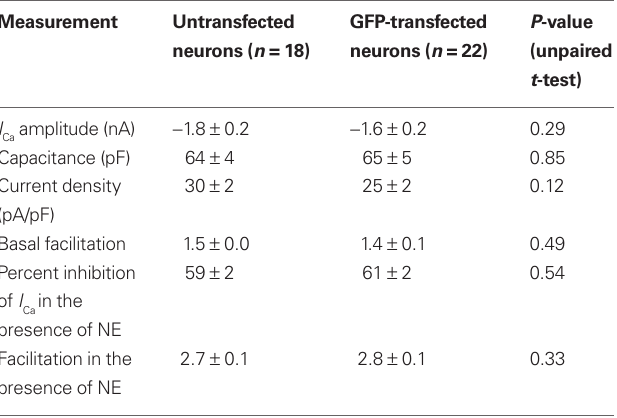
Table 1 | The effect of gFP mrNA transfection on Ca 2 + currents and Ne-mediated Ca 2 + current inhibition in SCg neurons. Characteristics of endogenous Ca 2 + currents were measured in untransfected SCG neurons and neurons transfected with 3.1 μg of GFP. Facilitation was calculated from the ratio of postpulse Ca 2 + -current amplitude to the prepulse current